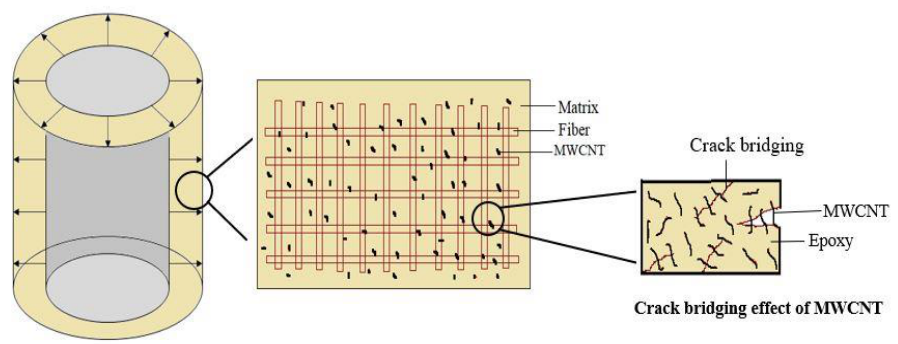
Figure 7. Schematic representation of bridging effect of MWCNT in epoxy.